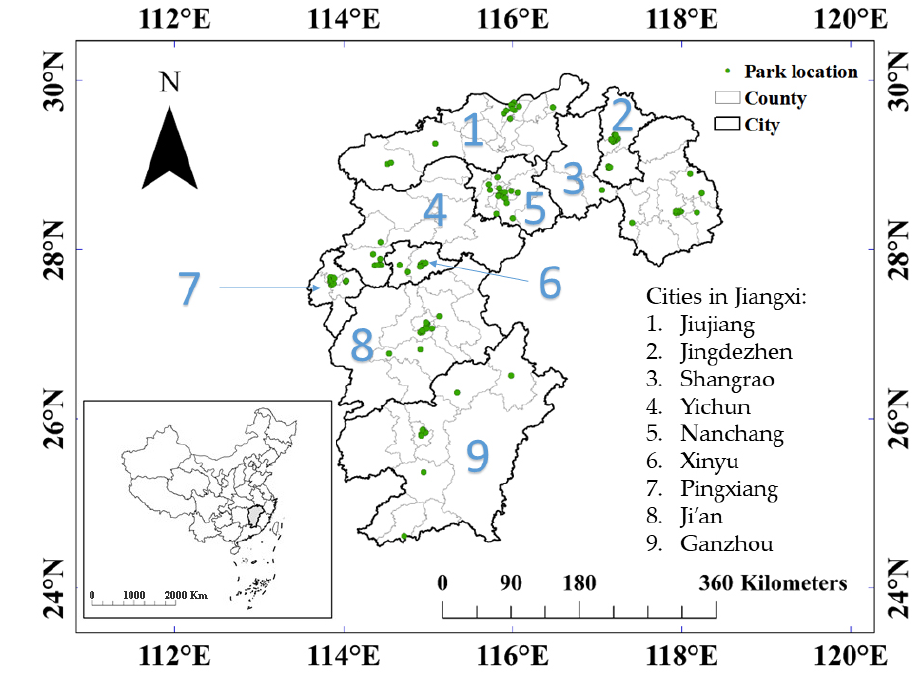
Figure 1. The geographical range of Jiangxi province in China and distributions of UWPs.